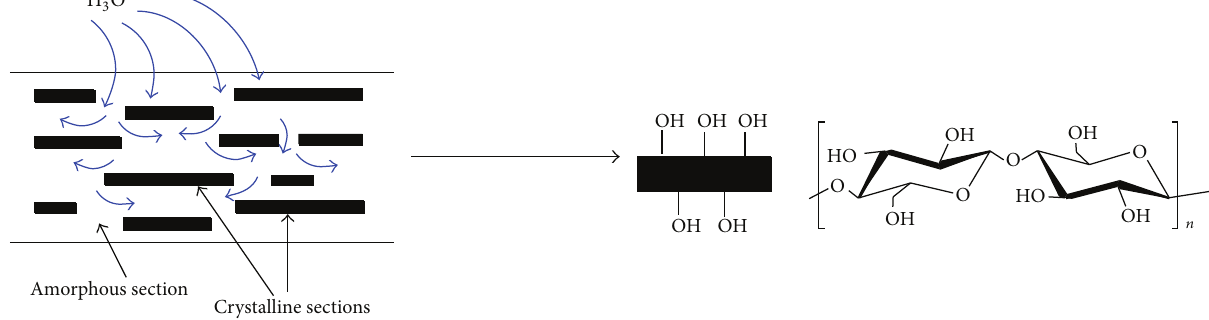
Scheme 1: Representation of the acid hydrolysis of cellulose and chemical structure of